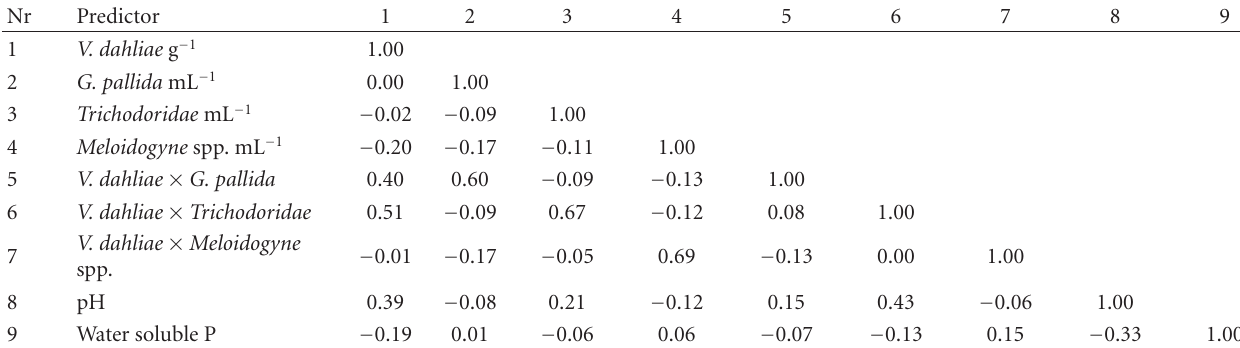
Table 2: The coe ffi cient of multiple determination, R 2 , of the global model for the three responses over the three years. In the global model, the nine predictors are present as well as the cultivar term. Between brackets, R 2 is given for the model with only the cultivar term.